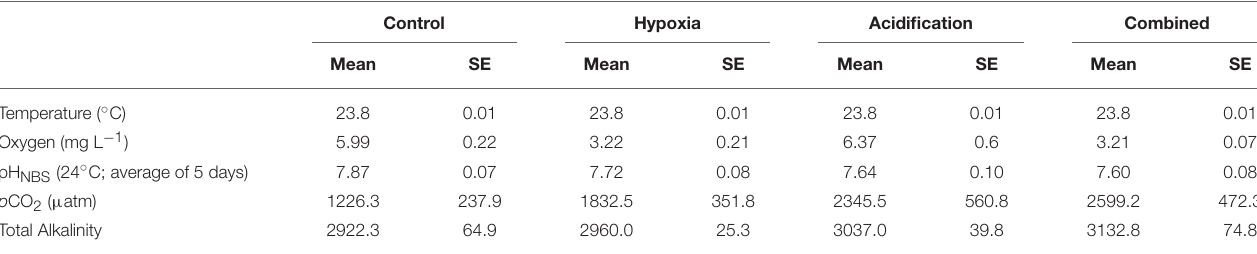
TABLE 1 | Measured conditions (mean ± SE) of the seawater of each treatment: Control (ambient p CO 2 and ambient O 2 ), Hypoxia (ambient p CO 2 and reduced O 2 ), Acidification (elevated p CO 2 and ambient O 2 ) and Combined (reduced O 2 and elevated p CO 2